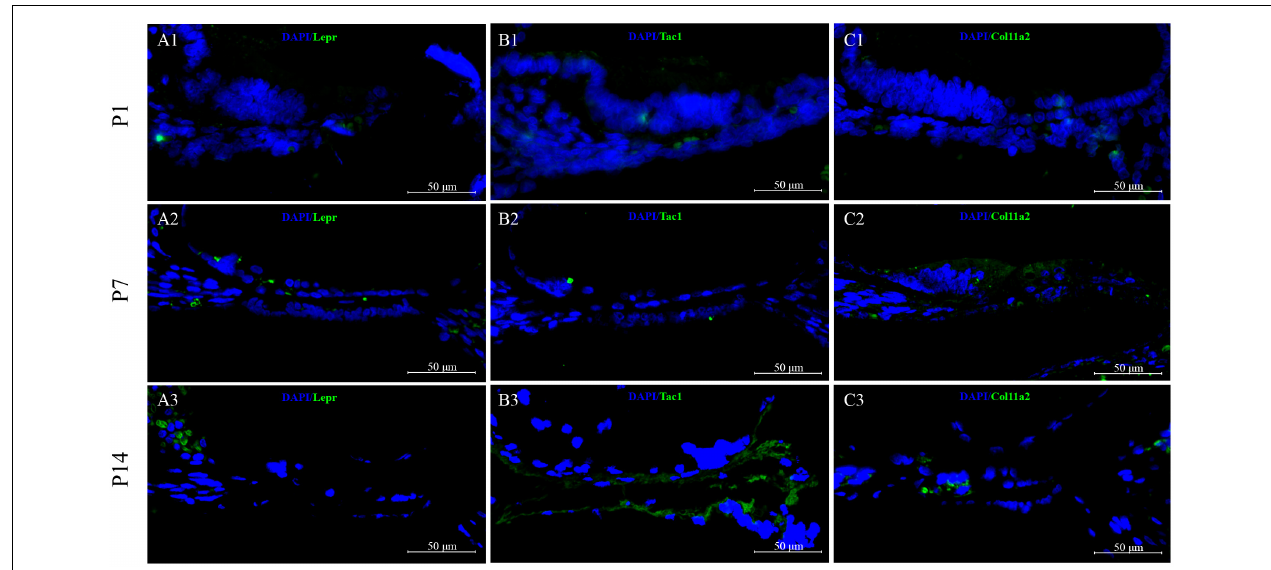
FIGURE 13 | Validation of high expression gene of GER cell clusters at P1, P7, and P14. Lepr was low expressed in the GER region at P1 (A1) , and upregulated expression in GER and inner hair cell region at P7 (A2) , but the expression was significantly reduced and almost disappeared at P14 (A3) . Tac1and Col11a2 were low expressed at P1 (B1,C1) but showed a significantly upregulated expression in GER at P7 (B2,C2) . While during the P14 period, Tac1and Col11a2 were nearly disappeared in the GER region and were centrally expressed in the hair cell region (B3,C3)